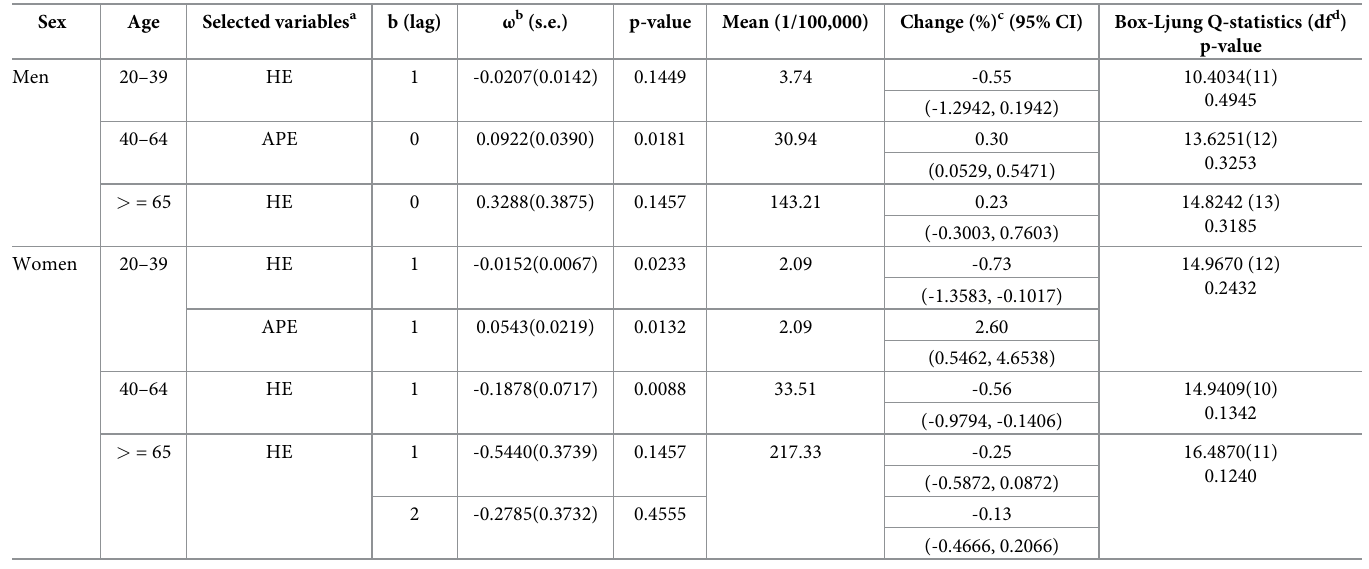
Table 5. Effects of socioeconomic factors on incidence rates of hospitalization due to hypertension in